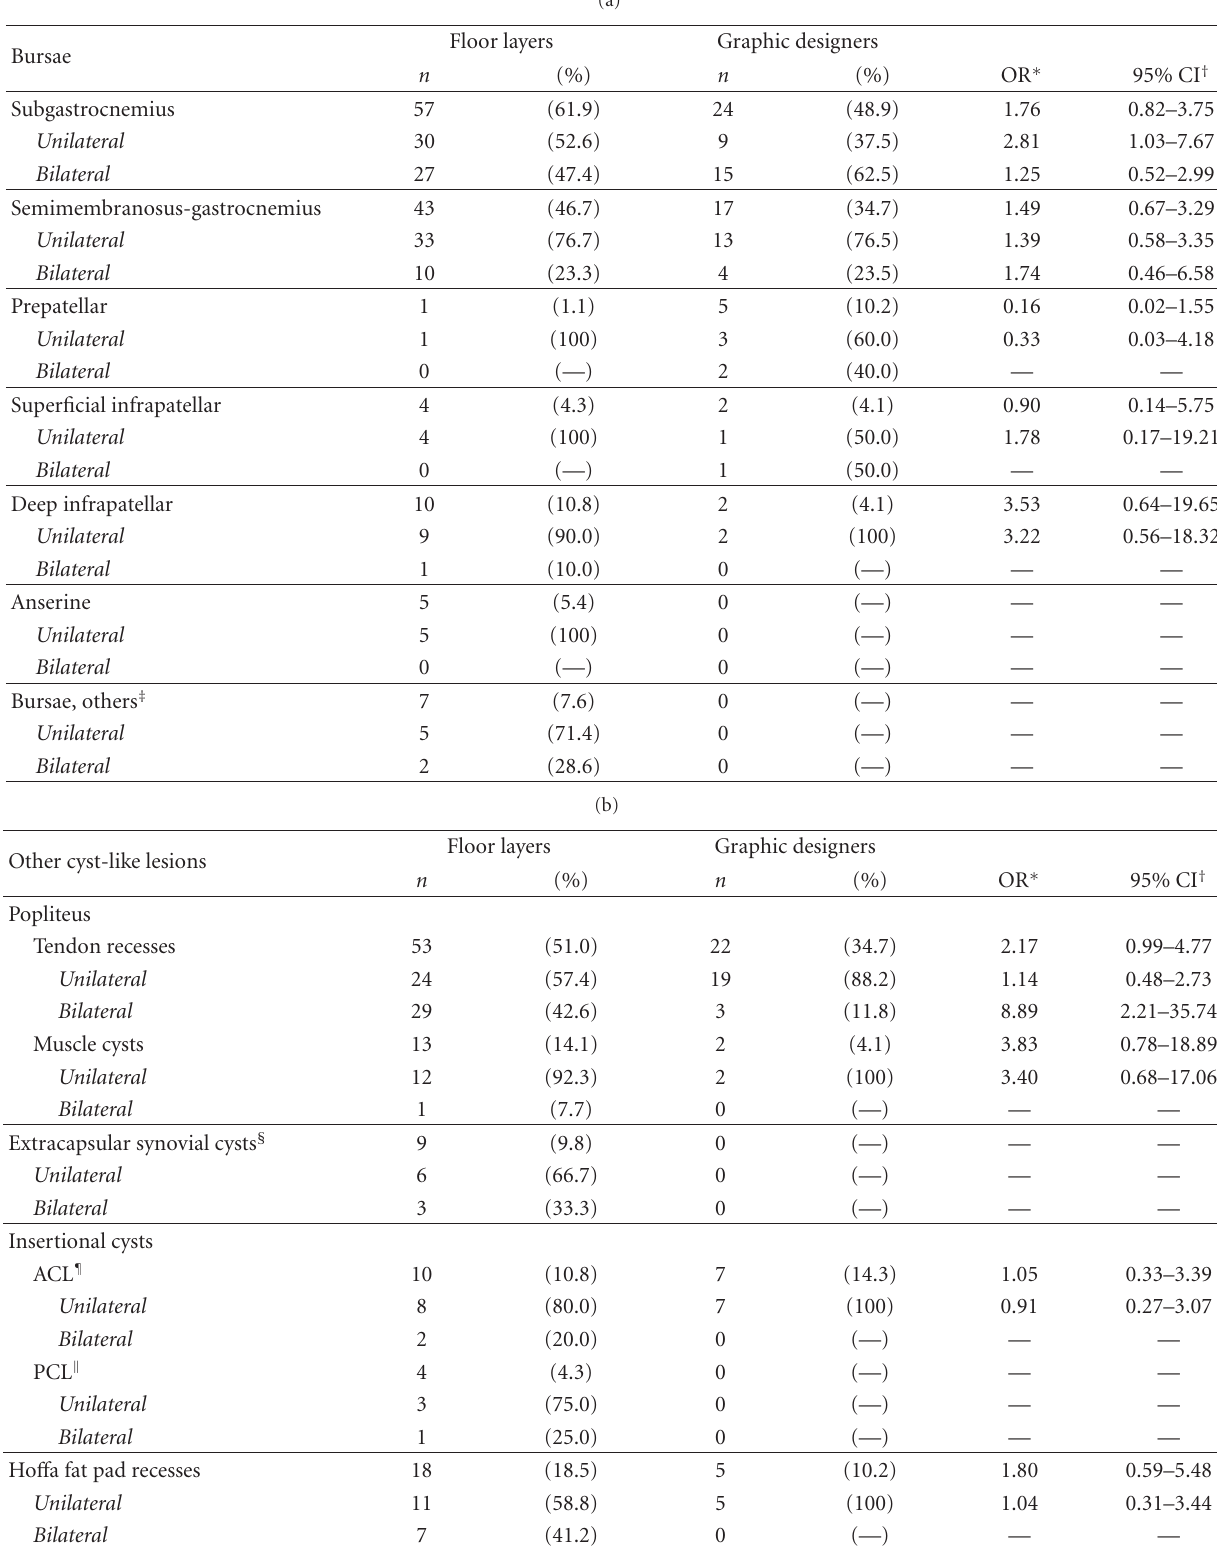
Table 2: (a) Proportion of fluid accumulation in various bursae among 92 floor layers compared to 49 graphic designers. (b) Proportion of other cyst-like lesions among 92 floor layers compared to 49 graphic